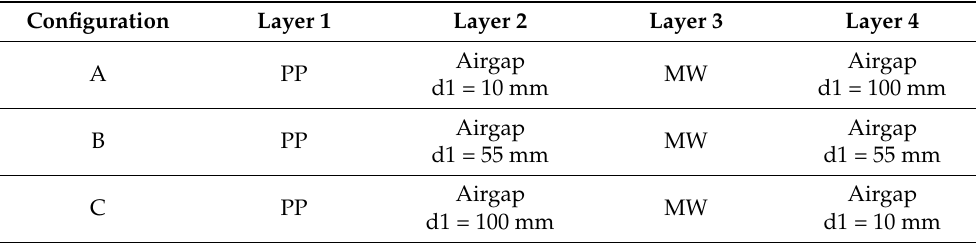
Table 2. Definition of the different layers for each system of the set of configurations.